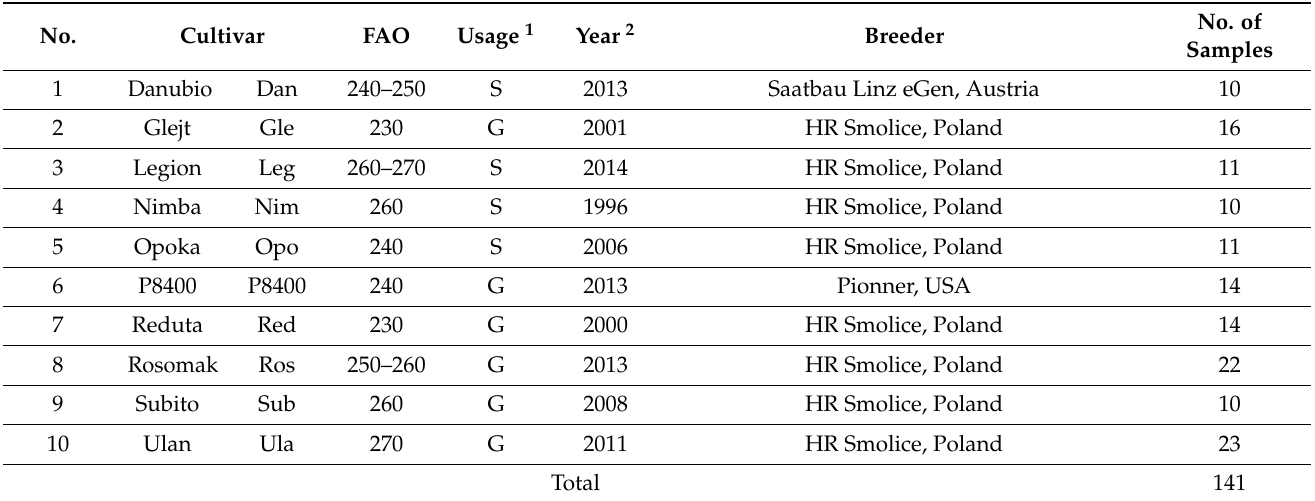
Table 2. Characteristics of maize cultivars and the number of samples taken.